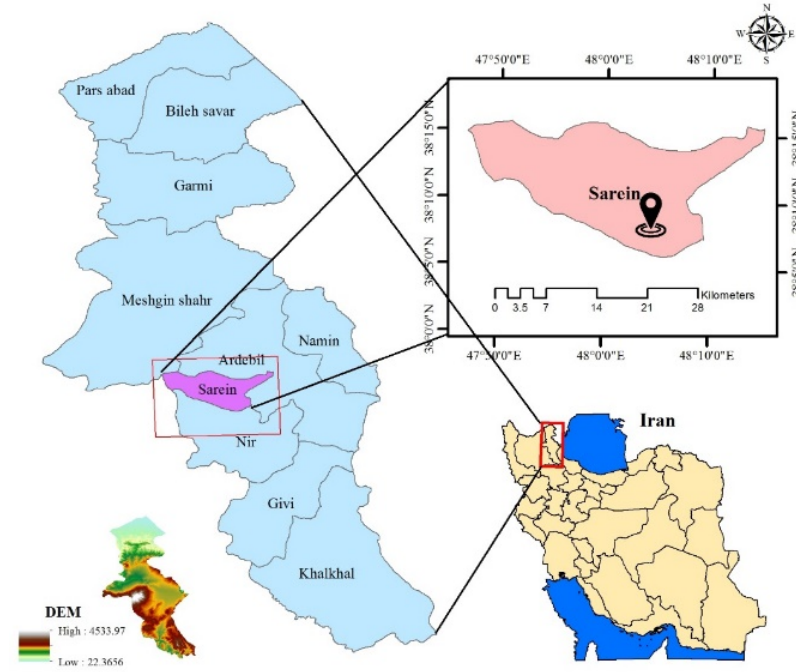
Figure 2. Location of Sarein in Ardebil province. Figure 2. location of Sarein in Ardebil province.